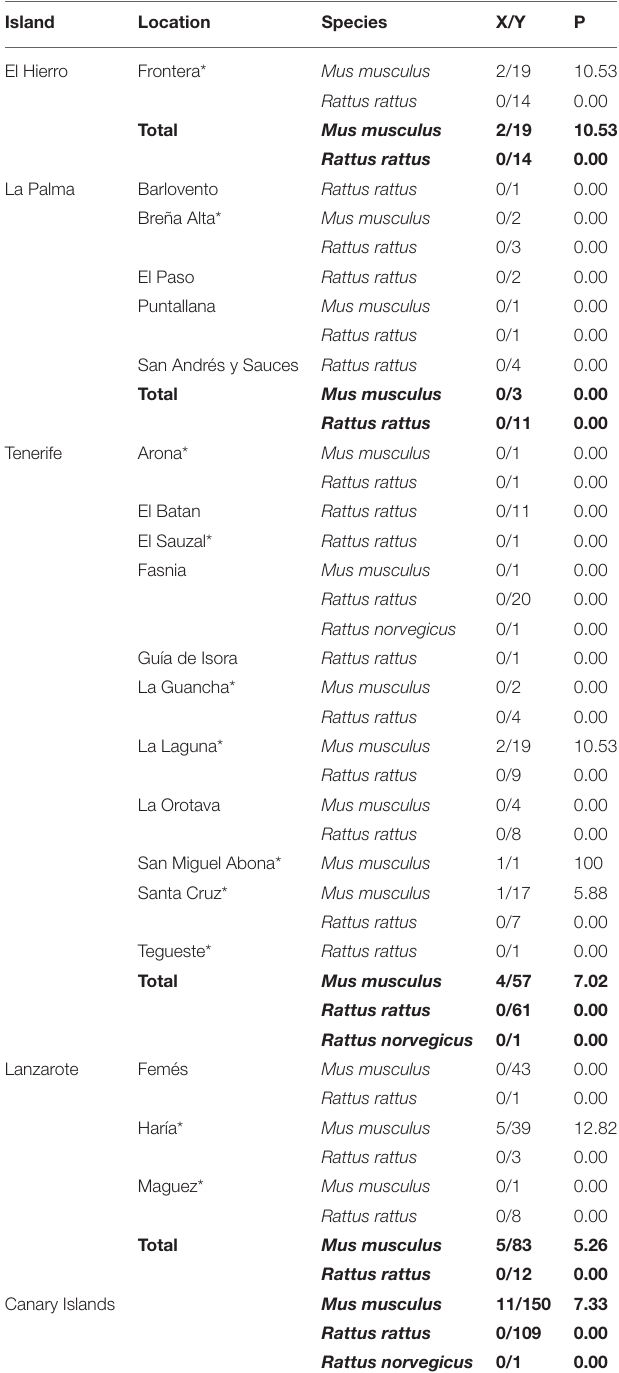
TABLE 1 | Prevalence of coronavirus in rodents belonging to Mus musculus , Rattus rattus and Rattus norvegicus species from Canary Islands